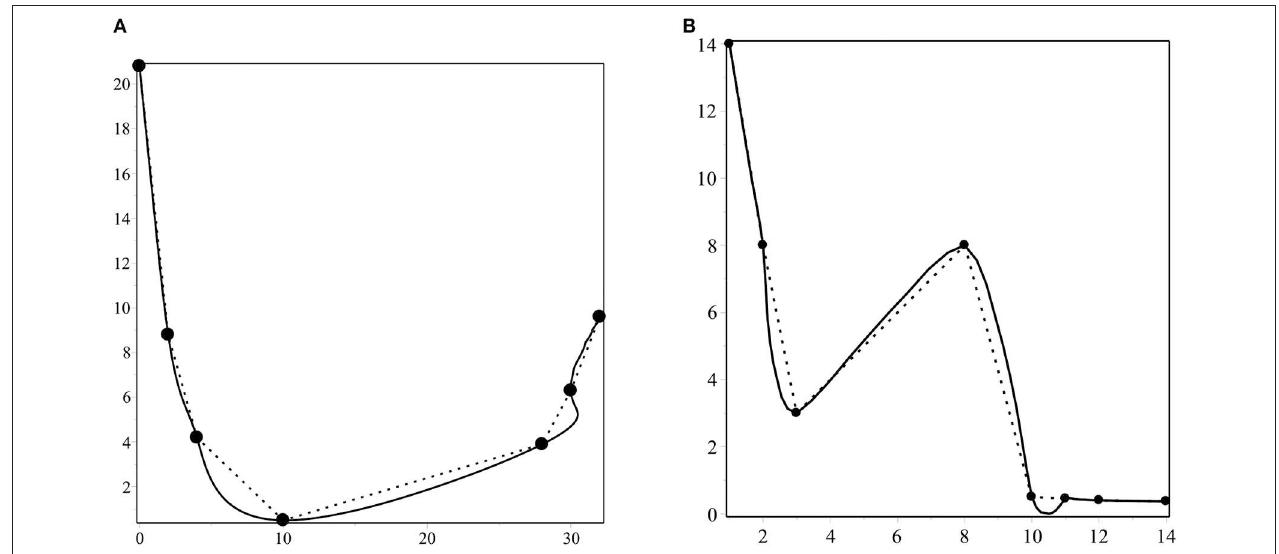
FIGURE 3 | The positivity-preserving curves generated by the four-point scheme (1) for positive initial data.